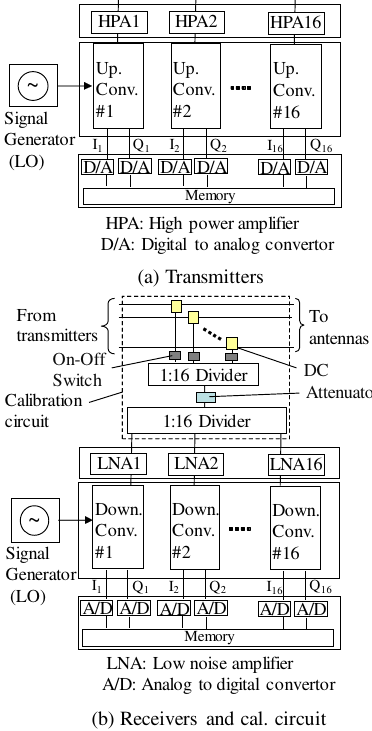
Figure 5. Testbed configuration: ( a ) Transmitters, and ( b ) Receivers and calibration